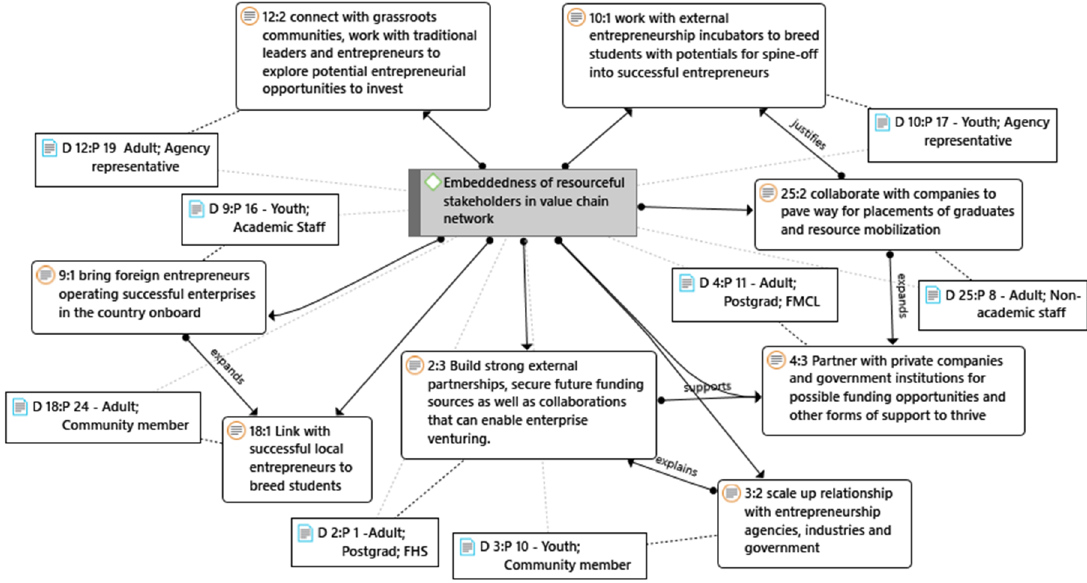
Figure 5. Embedding resourceful stakeholders in the value-chain network.